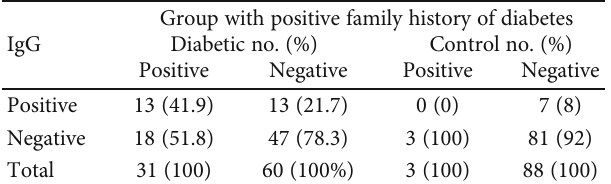
Table 5: Anti- Toxoplasma IgG and family history distribution in both groups.